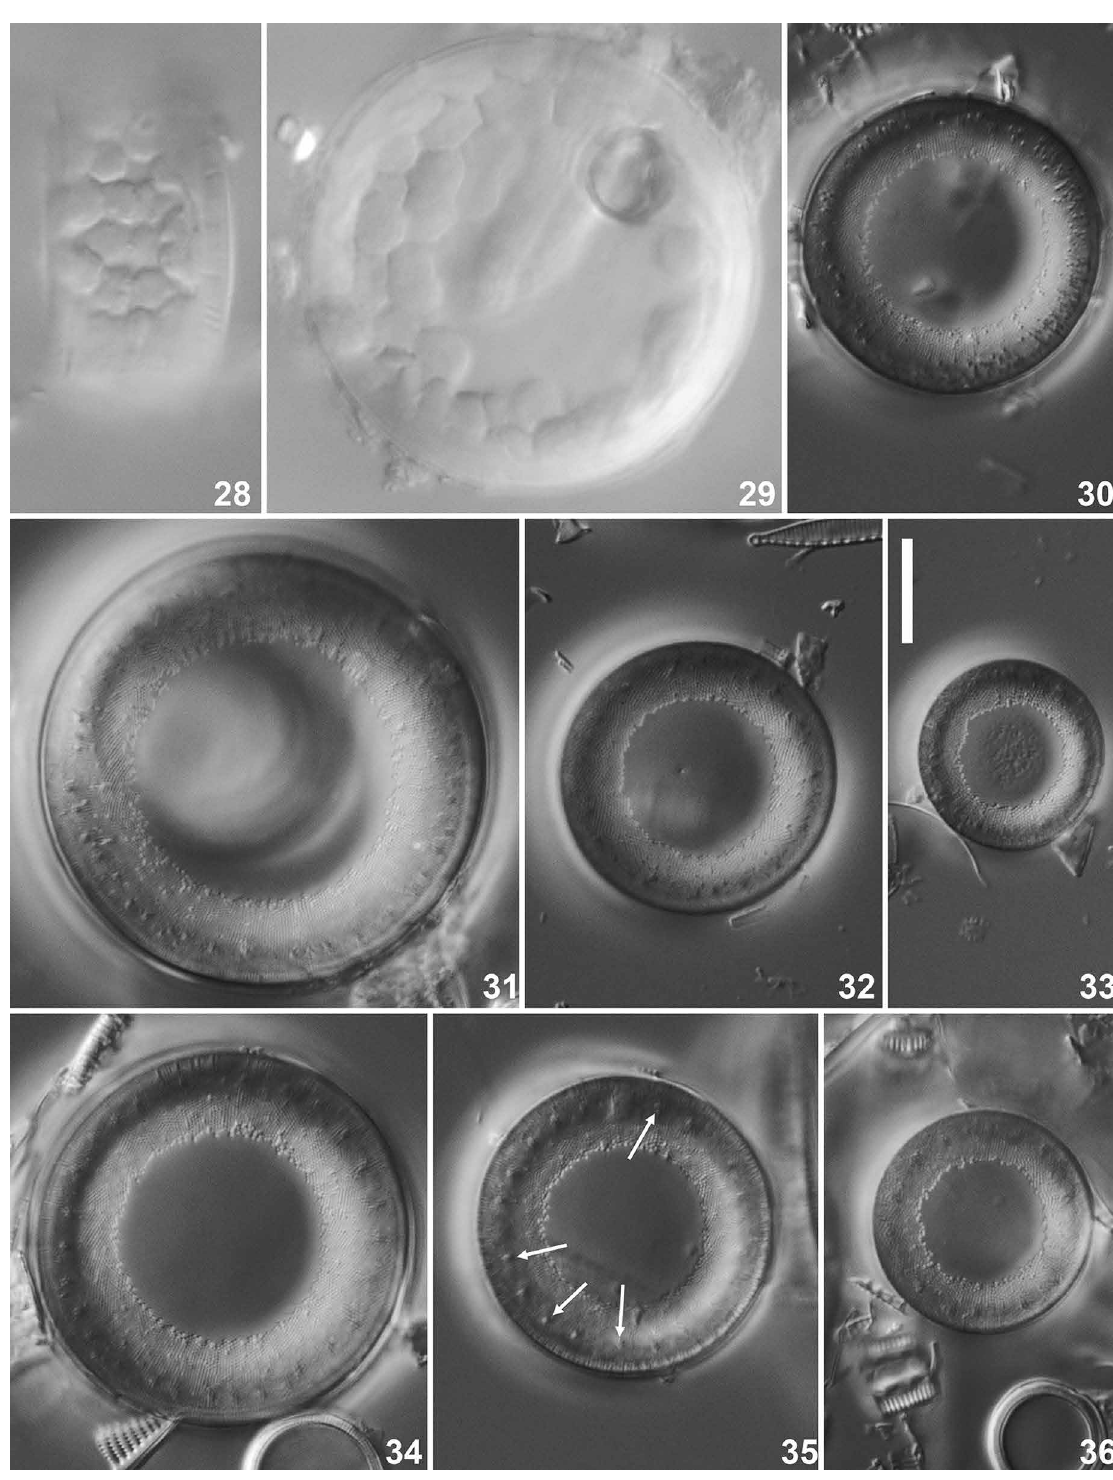
Figs 28–36. Angusticopula cosmica Goeyers & Van de Vijver sp. nov. LM. Campbell Island holotype population, sample BAS303 (BR-4577). 28 . Frustule in girdle view showing the discoid chloroplasts. 29 . Frustule in valve face view showing the discoid chloroplasts. 30–36 . Several valves in valve face view showing clearly the submarginal ring of rimoportulae (arrows) and the striated valve face margin. Scale bar = 10